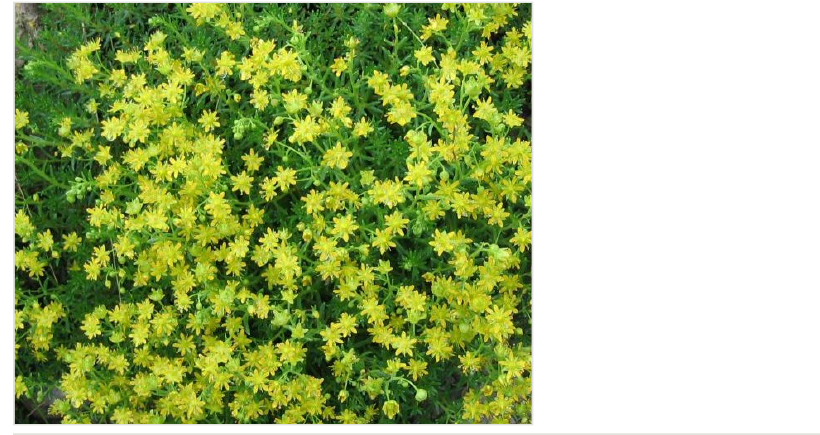
Figure 1. Saxifraga aizoides is a fl owering herb of the genus Saxifraga, which lives in Europe and North